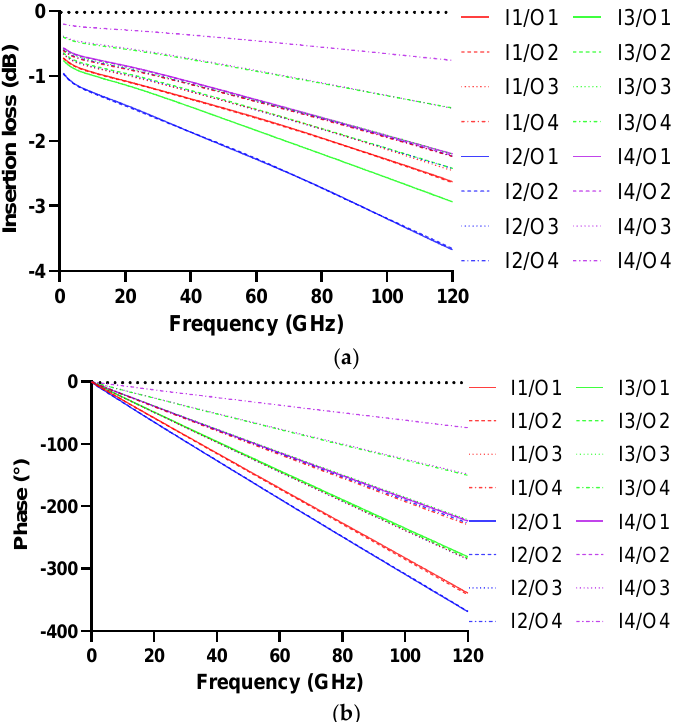
Figure 11. Simulated ( a ) insertion losses and ( b ) phase lengths (in degree) of all the connections of the 4 × 4 staircase switch matrix.